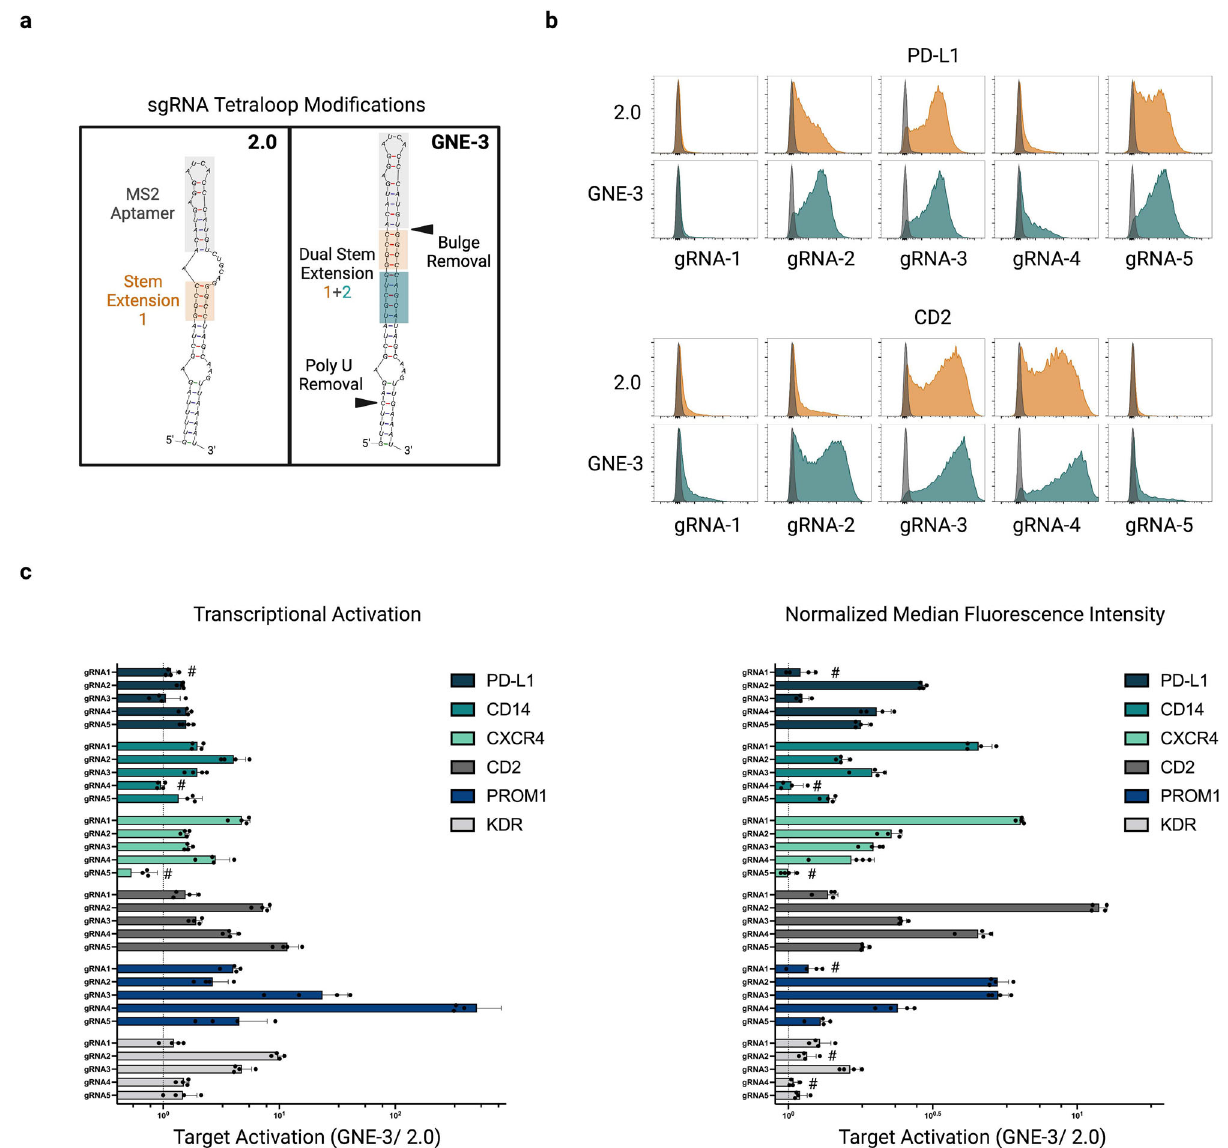
Fig. 2 | Relative CRISPRactivationef fi ciency ofsgRNAs withanoptimized MS2 aptamer-containingscaffold.a StructurediagramoftheMS2-aptamercontaining tetraloopinthe2.0sgRNAformat 13 (left)oranoptimizedtetraloopstructure(right and Supplementary Fig. 3). The optimized GNE-3 tetraloop contains an additional stem extension and removal of a polyU tract 21 . In addition, the bulge region con- necting the MS2 aptamer and stem extension region 1 in the 2.0 format has been removed. b Flow cytometric analysis of target gene activation by sgRNAs with eithera2.0(orange)orGNE-3(teal)scaffoldcontext.Representativehistogramsof analyzedK562CRISPRa-selpopulationsinfectedwith fi vedistinctspacersequences targeting the promoter proximal region of PD-L1 (top) or CD2 (bottom).